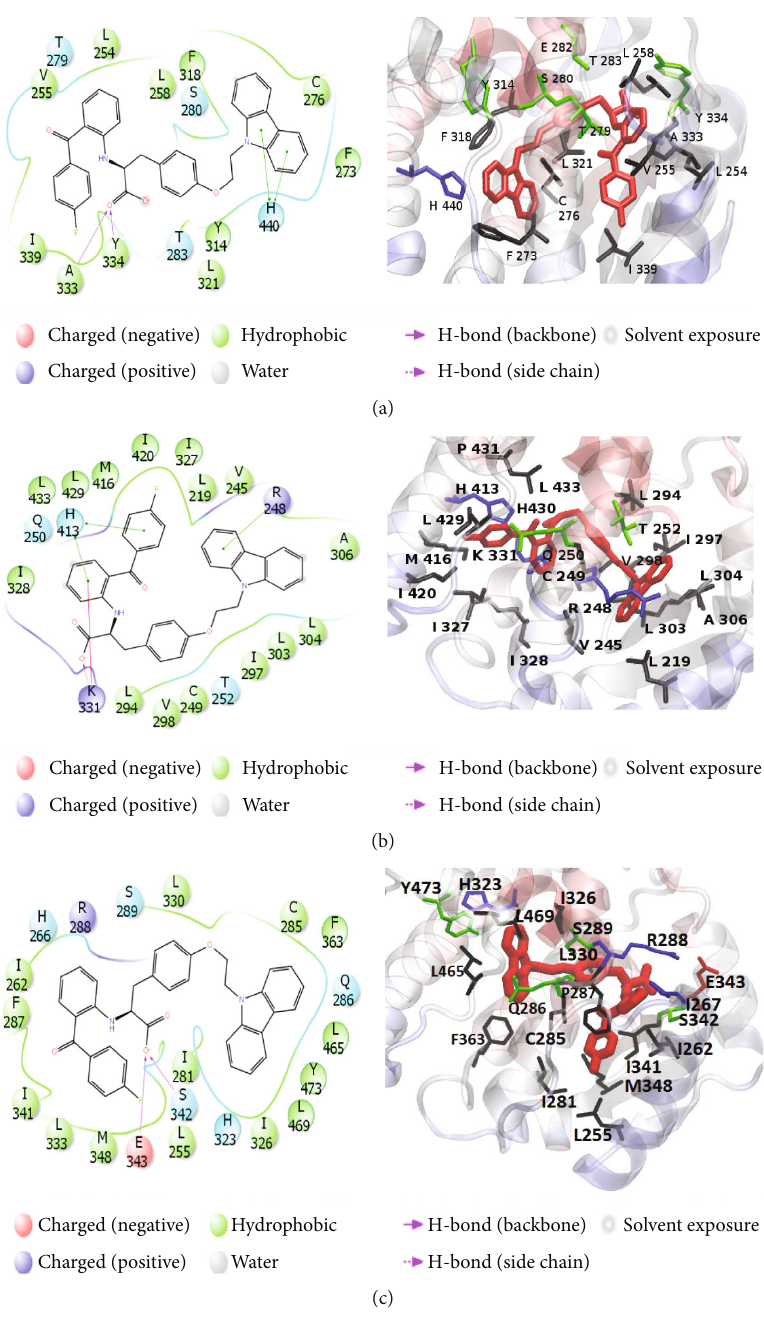
Figure 5: Two- and three-dimensional interaction diagrams of chiglitazar ’ s binding pose in complex with the PPAR α (a), PPAR β (b), and PPAR γ (c) receptors from the most abundant cluster of the combined MD